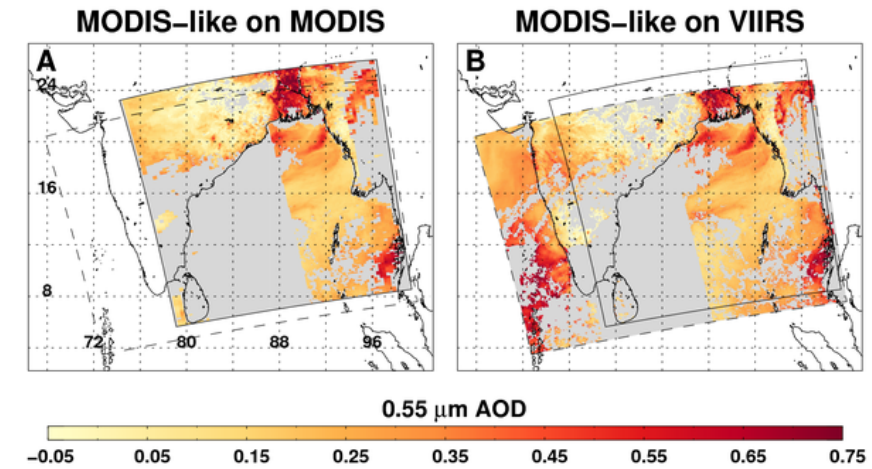
Figure 6. QA-filtered AOD at 0.55µm over the Bay of Bengal on 5 March 2013 at 07:35, retrieved with MODIS-like algorithm on (a) MODIS (at 10km) and (b) VIIRS (at 7.5km). This is the same observational overlap as pictured in Fig. 2.